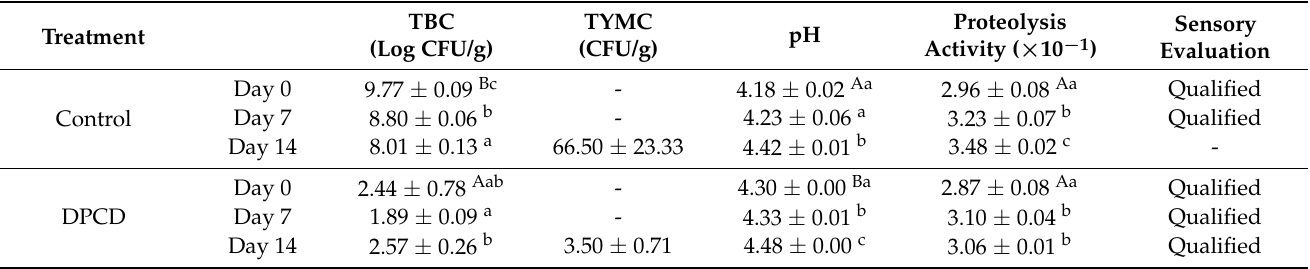
Table 3. Total bacterial count (TBC), total yeast and mold count (TYMC), pH, proteolysis activity and sensory evaluation of control and DPCD processed quark cheese stored at 4 ◦